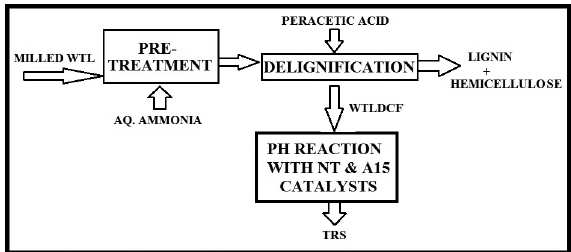
Figure 2. Block diagram of the overall process for environmental impact assessment using “gate to gate”